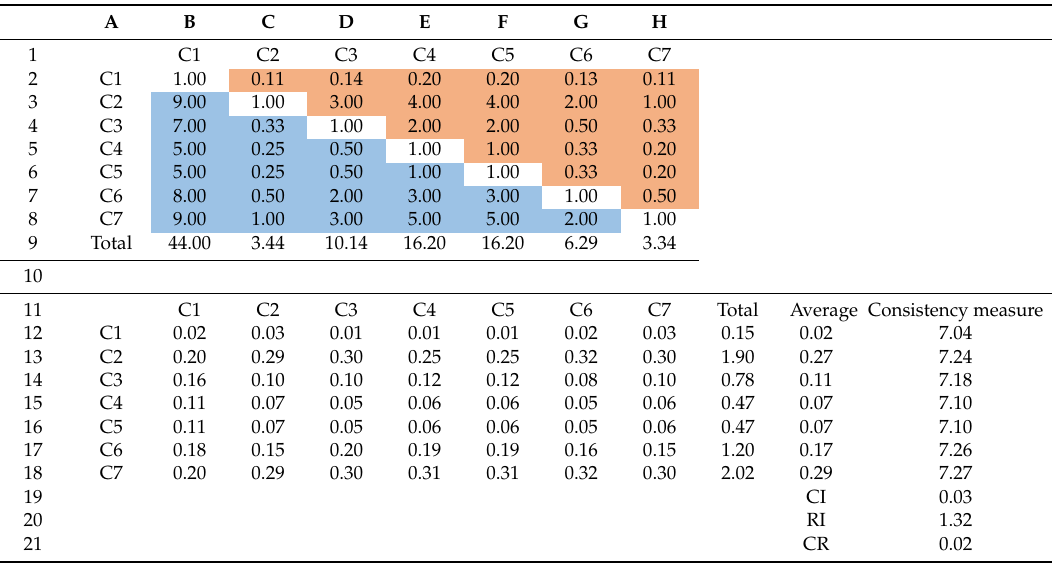
Table 7. Illustrative example for the explanation of the AHP